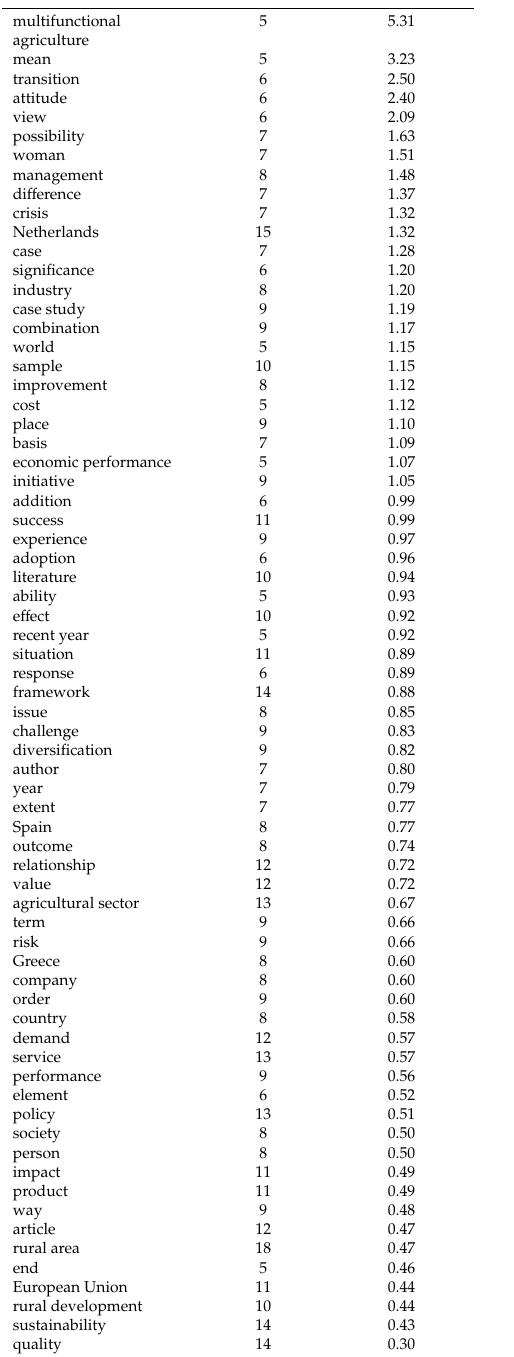
Table 1. Number of occurrences and respective relevance of each term.